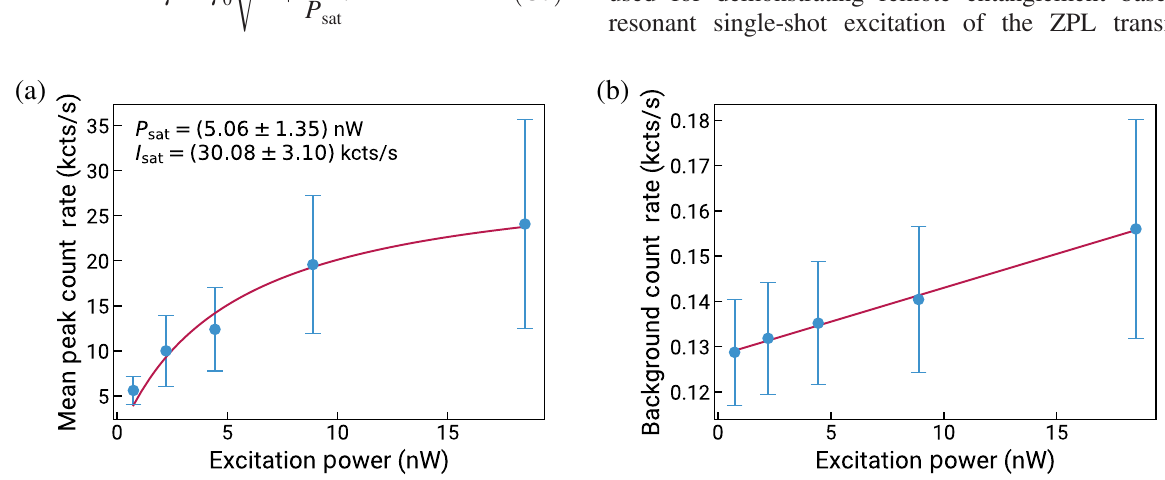
FIG. 7. Saturation measurement. (a) Mean peak count rate as a function of the resonant excitation power (scan speed 6 GHz = s) extracted from the excitation power-dependent PLE measurements. The error bars are given by the standard deviations. The fit function is from Eq. (C6). The background at the corresponding excitation power was already subtracted. (b) Background count rate increasing linearly with excitation power. The intercept at zero excitation power is at 128